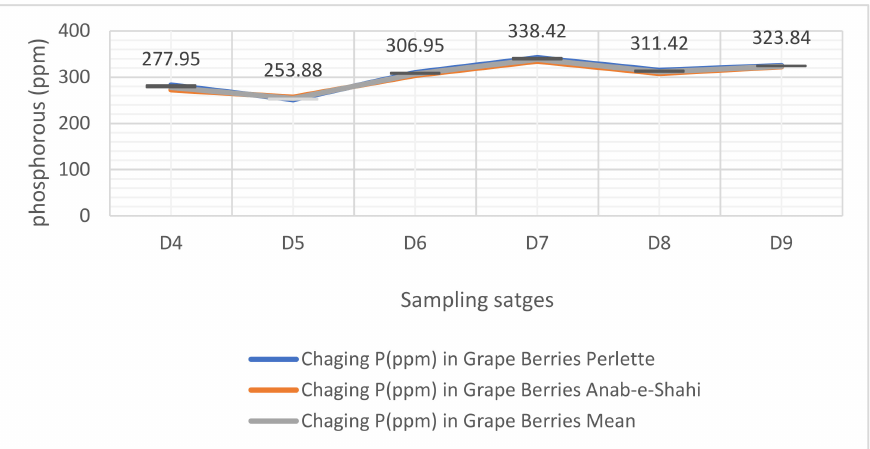
Figure 2. Change of Phosphorus (ppm) concentration during the development of berries in grapes cv. Perlette and Anab-e-Shahi.